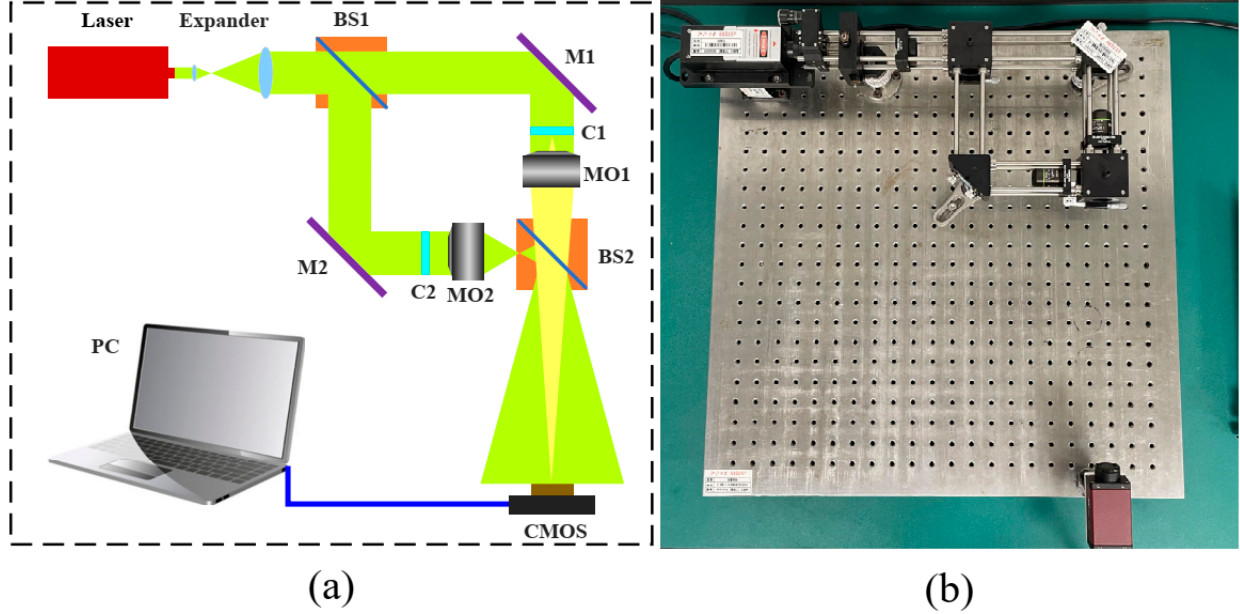
Figure 2. ( a ) Diagram of the DHM optical system. ( b ) The setup of the experimental device.